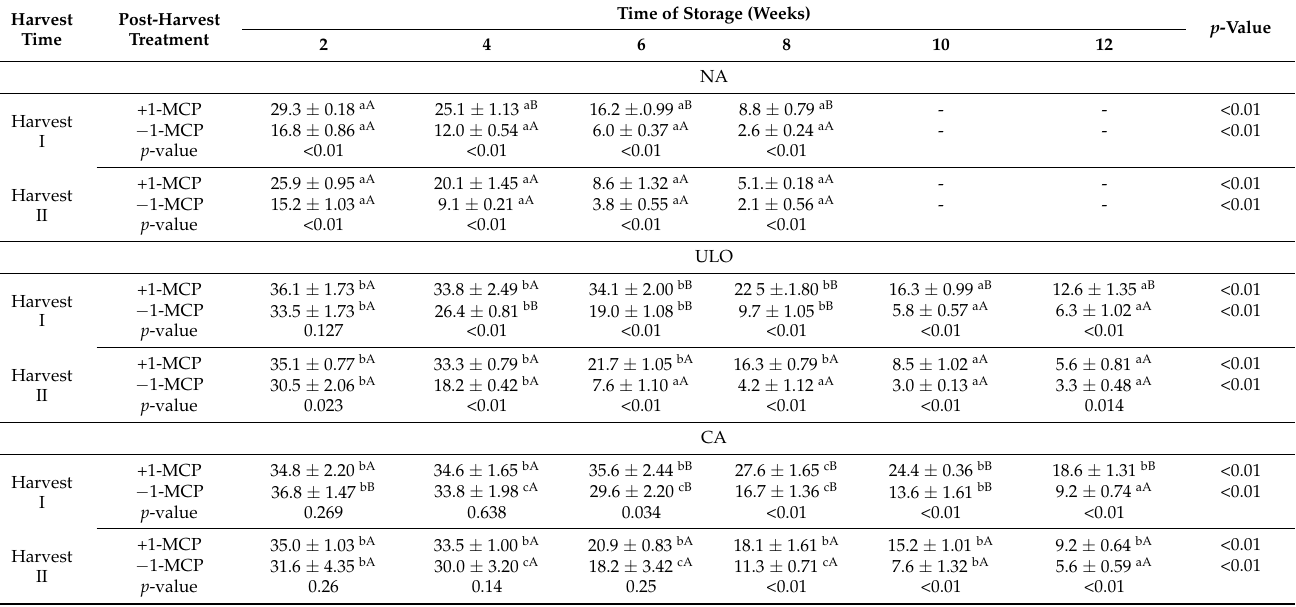
Table 2. Changes of firmness [N] measured in ‘Geneva’ mini kiwi fruit in the post-harvest period.